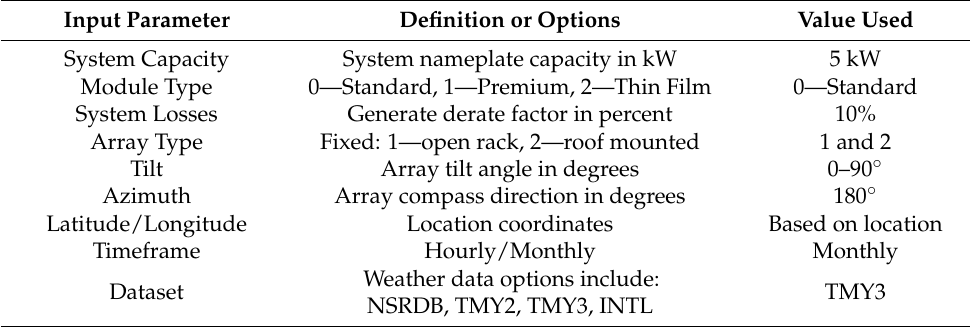
Table 1. Parameters used in the PVWatts simulation